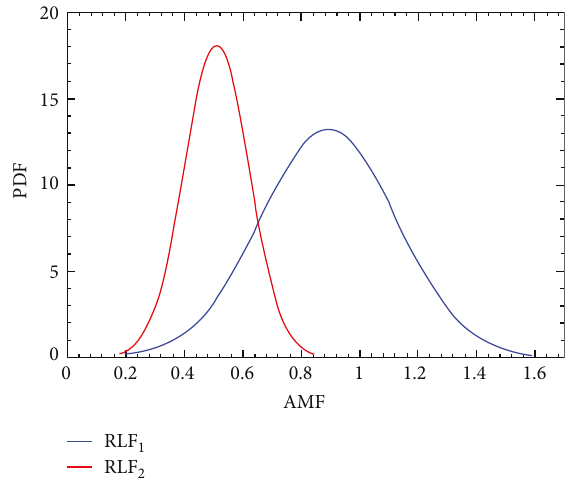
Figure 16: Sensitivity to mistuning levels ( E = 2 = 7% ). b